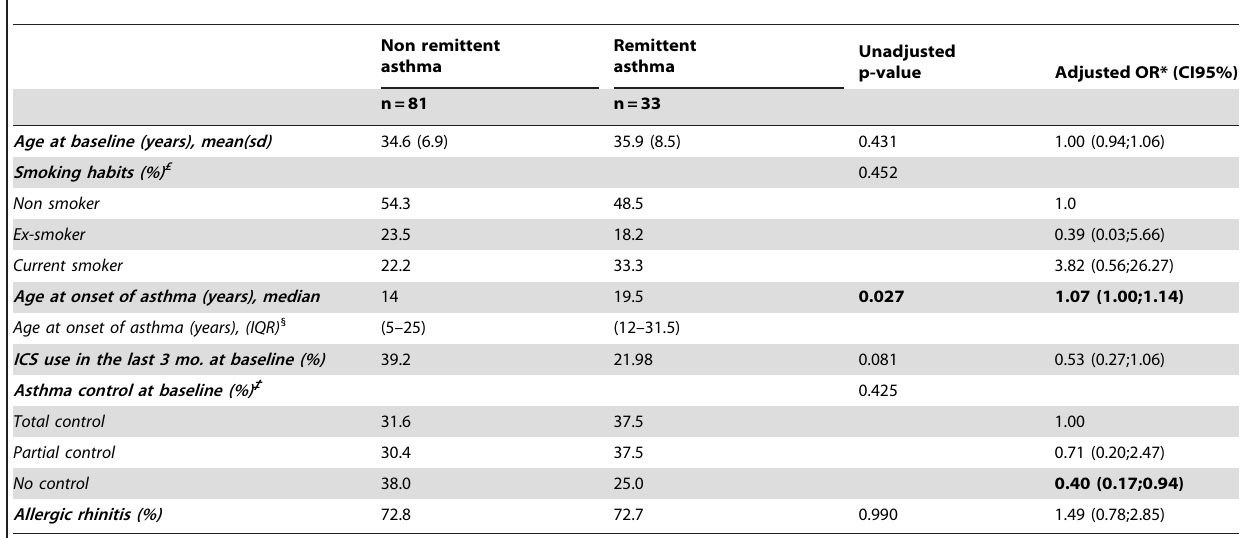
Table 3. Main baseline characteristics of the women with non remittent asthma and with remittent asthma at follow-up and adjusted Odds Ratios* (CI95%) for the effects of these variables reported at baseline on asthma remission at